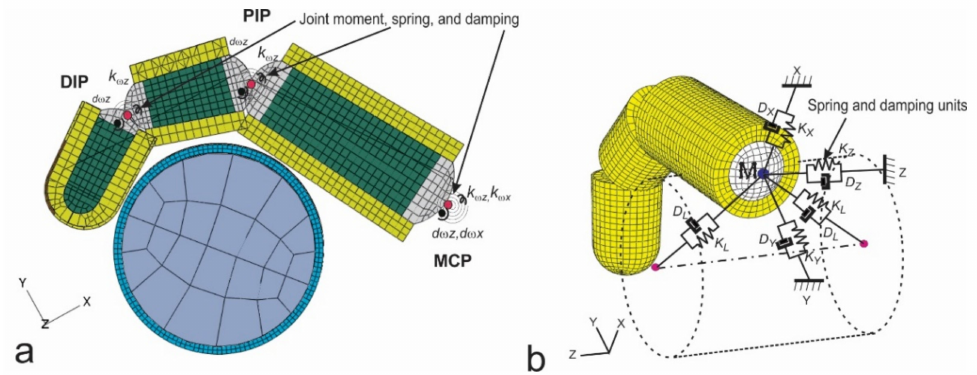
Figure 11. A 3D finite element model of a finger gripping a cylindrical handle [117]: ( a ) The con- nection of the finger segments by rotational connective elements at the DIP, PIP, and MCP joints; and ( b ) The additional translational, connective elements at the MCP joint